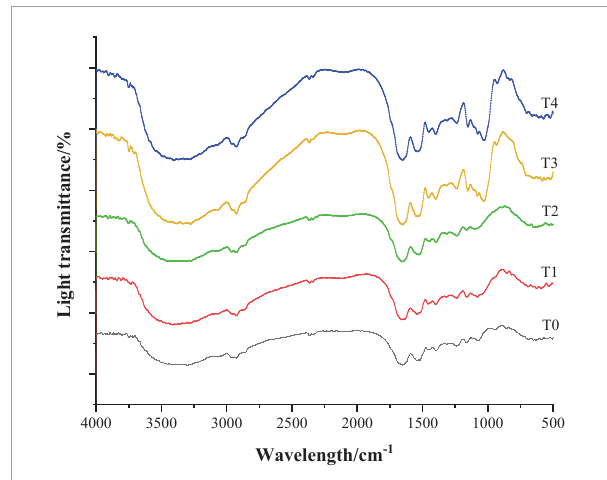
FIGURE4 Infrared spectrum of composite dietary fiber-MP composite gel. T0: control group; T1: 6.06% chaff dietary fiber; T2: 6.06% soybean hull dietary fiber; T3: 6.06% inulin; T4: 1.40% chaff dietary fiber + 1.42% soybean hull dietary fiber + 3.24% inulin.